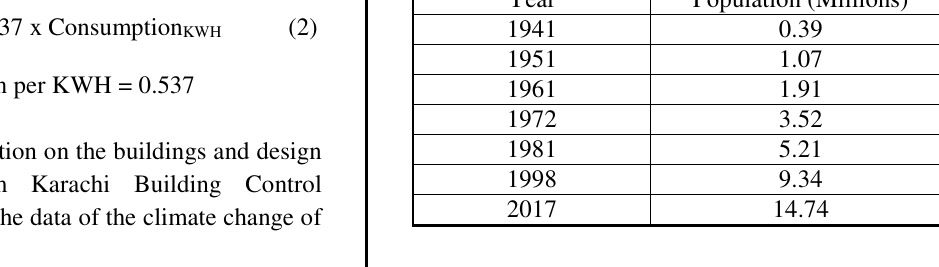
Fig. 1: Urban Population of Karachi (Source: Pakistann Beareau of Statistics) Table 1: Population of Karachi (Source: Pakistan Beareau of